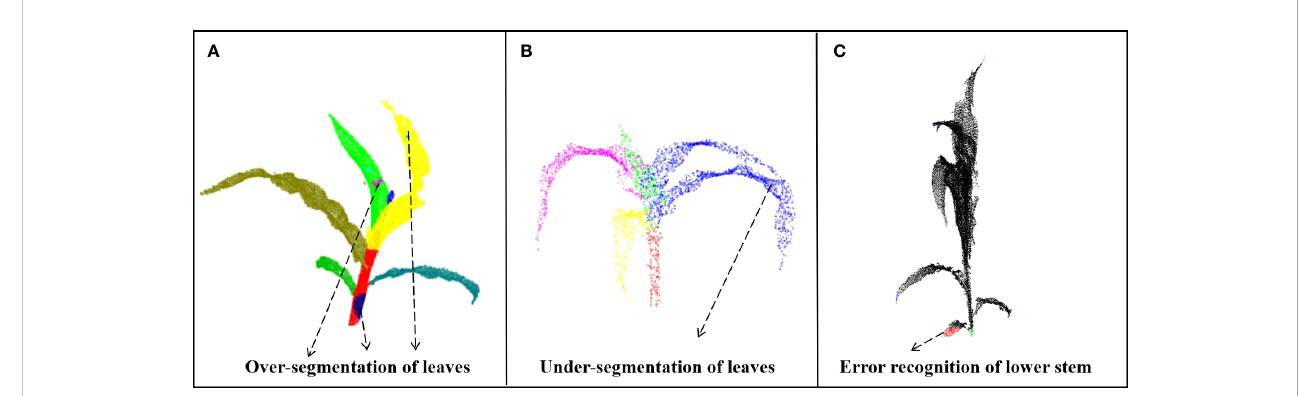
FIGURE 11 Limitations of the our algorithm. (A) Over segmentation of leaves. (B) Under segmentation of leaves. (C) Error recognition of lower